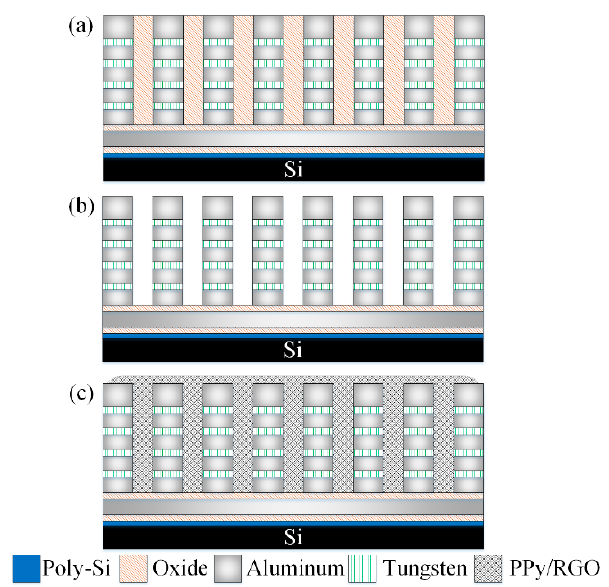
Figure 8. Manufacturing flow for the AGS; ( a ) after the CMOS process, ( b ) etching the oxide layer, and ( c ) coating the sensitive film.